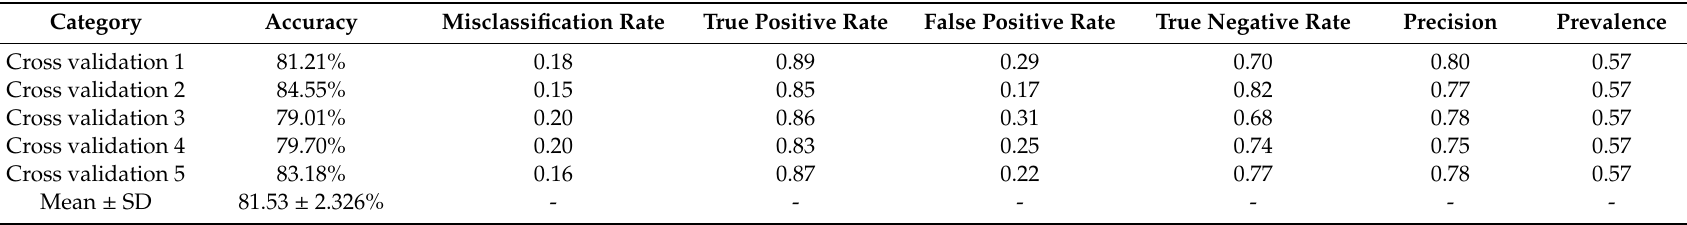
Table 4. Accuracy, misclassification rate, true positive rate, false positive rate, true negative rate, precision, prevalence, and mean and standard deviation of accuracy. Category Accuracy Misclassification Rate True Positive Rate False Positive Rate True Negative Rate Precision Prevalence Cross validation 1 81.21% 0.18 0.89 0.29 0.70 0.80 0.57 Cross validation 2 84.55% 0.15 0.85 0.17 0.82 0.77 0.57 Cross validation 3 79.01% 0.20 0.86 0.31 0.68 0.78 0.57 Cross validation 4 79.70% 0.20 0.83 0.25 0.74 0.75 0.57 Cross validation 5 83.18% 0.16 0.87 0.22 0.77 0.78 0.57 Mean ± SD 81.53 ± 2.326% - - - - -